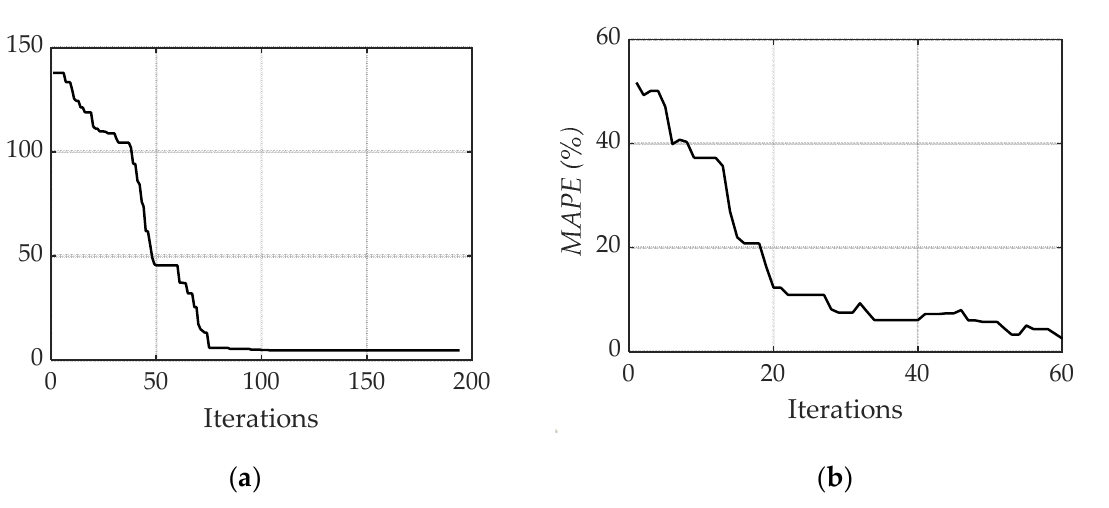
Figure 13. Iterative evolution curves of parameter identification of two motor efficiency models. ( a ) 8 kW motor; ( b ) 5 kW motor.